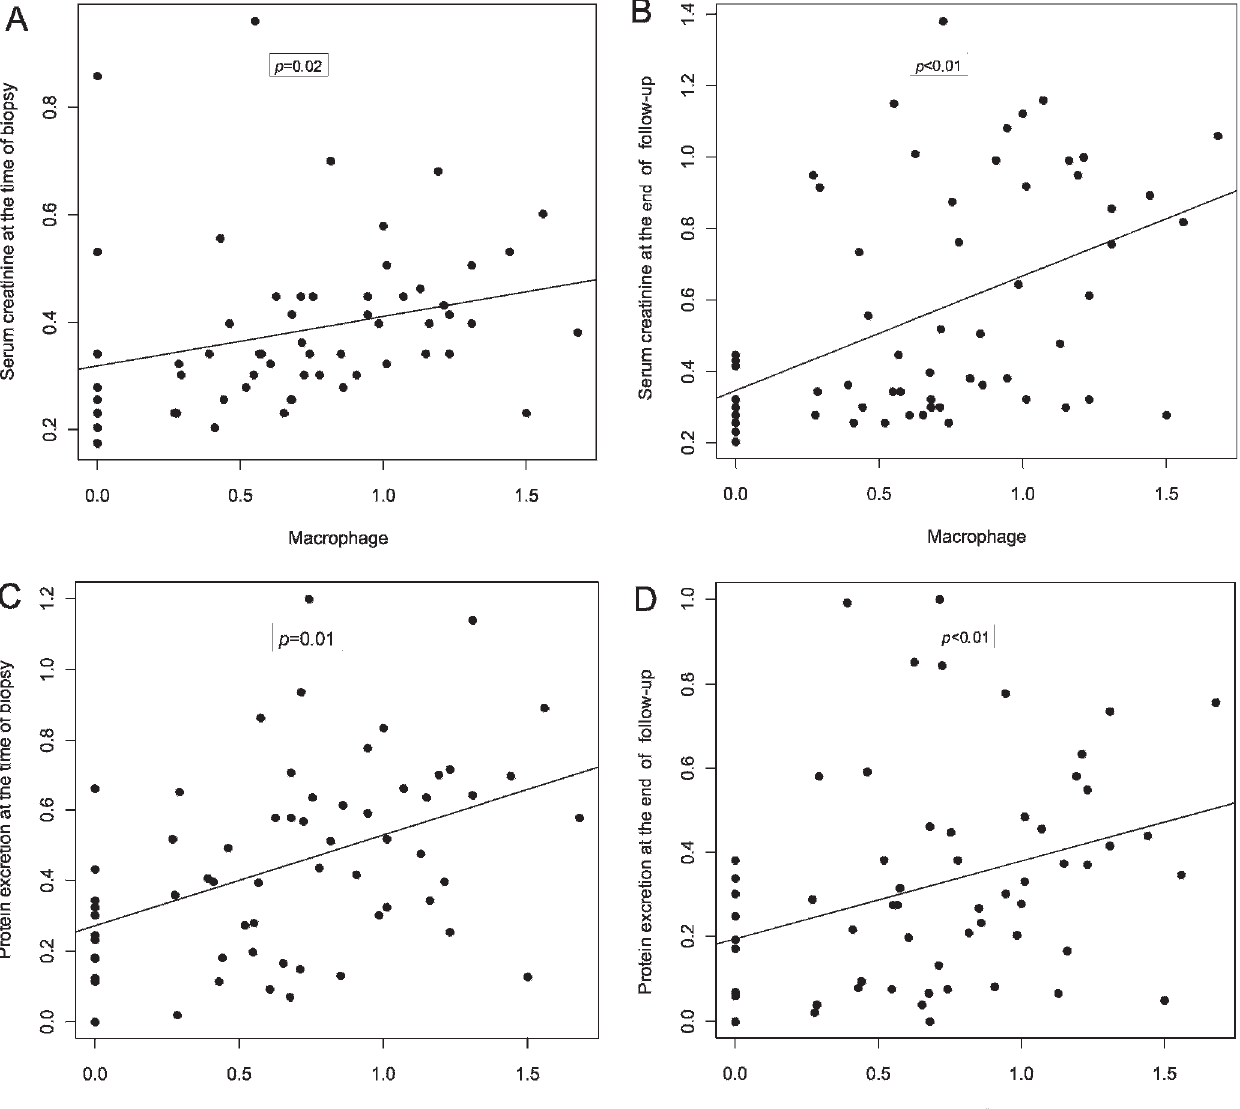
Figure 2 - Correlations between the number of cortical macrophages and the following variables: (A) serum creatinine (mg/dL) at the time of biopsy ( p =0.02; r=0.28); (B) serum creatinine at the end of follow-up ( p , 0.01; r=0.46); (C) protein excretion (g/24h) the time of biopsy ( p =0.01; r=0.44); and (D) protein excretion at the end of follow-up ( p , 0.01;